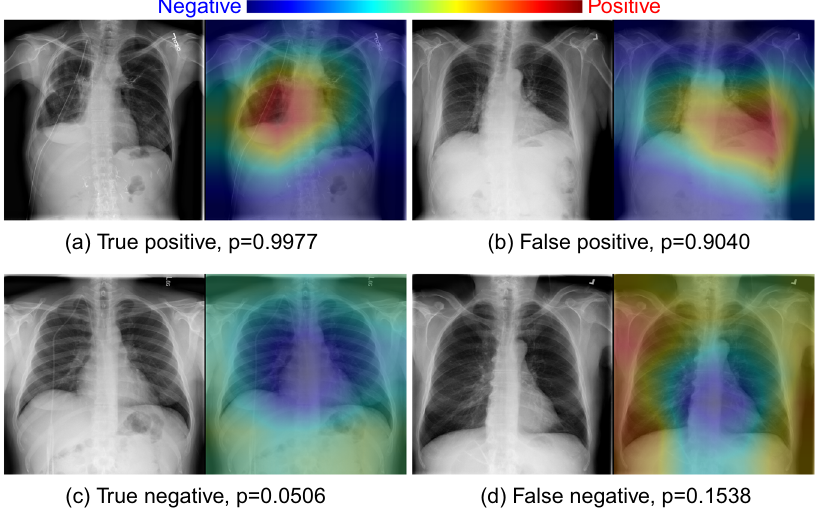
Fig. 4 Model visualization. For each group of images, left is the original radiograph, right is the heatmap overlaid on the radiograph. The areas marked with a peak in heatmap indicate the prediction of abnormalities with high probabilities. a Findings: right lung pneumothorax. All four radiologists labeled it as abnormal. CNN model predicts it as abnormal with a con fi dence score of 0.9977. b Impression: no evidence of lung in fi ltrate thoracic infection. Two of four radiologists labeled it as normal, the other two labeled it as abnormal. Model prediction: abnormal, score: 0.9040. c Impression: normal chest. All four radiologists labeled it as normal. Model prediction: normal, abnormality score: 0.0506. d Findings: minimally increased lung markings are noted in the lung bases and perihilar area consistent with fi brosis unchanged. Two of four radiologists labeled it as abnormal, the other two labeled it as normal. Model prediction: normal, score: 0.1538. Findings and impressions were extracted from the associated text